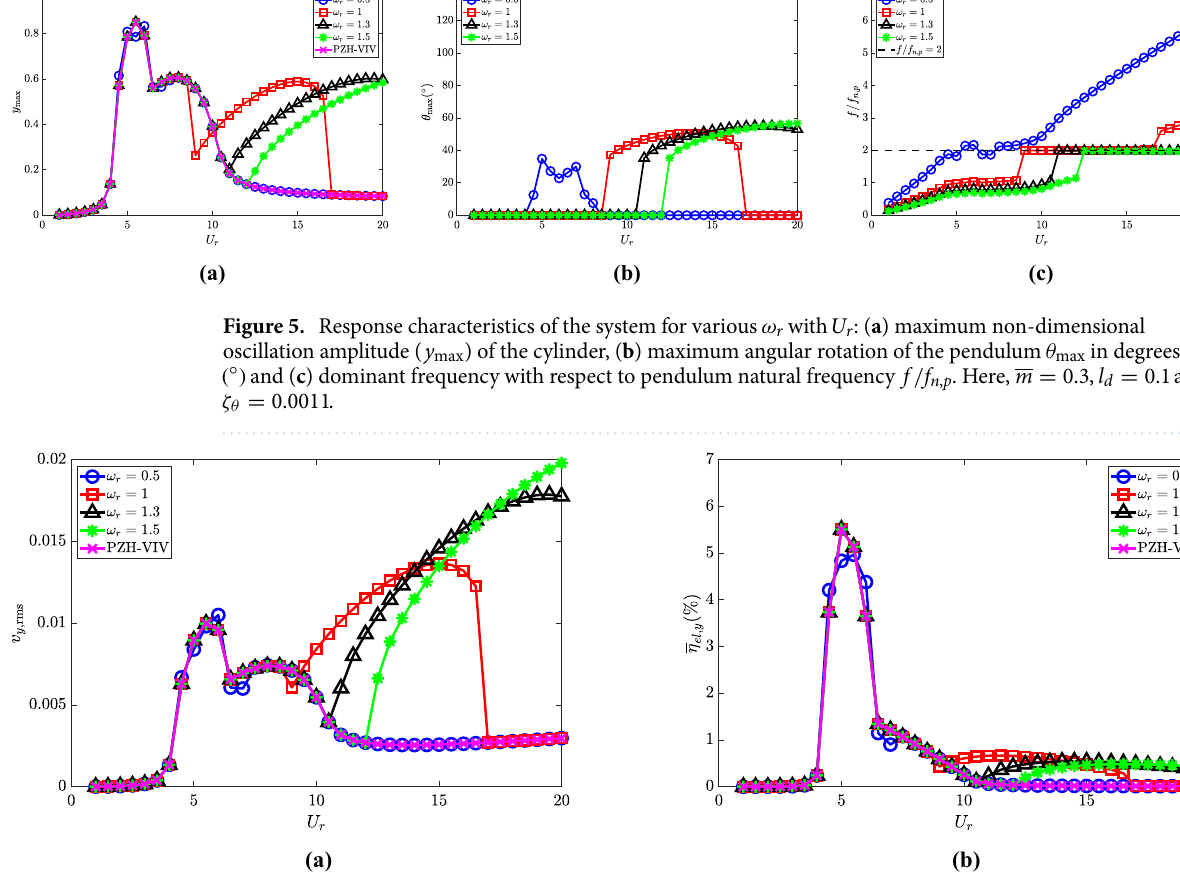
Figure 6. Effect of ω r in the introduction of NRGP with U r on: ( a ) electric tension v y ,rms , and ( b ) energy harvesting efficiency η el , y . Here, m = 0.3 , l d = 0.1 and ζ θ = 0.0011